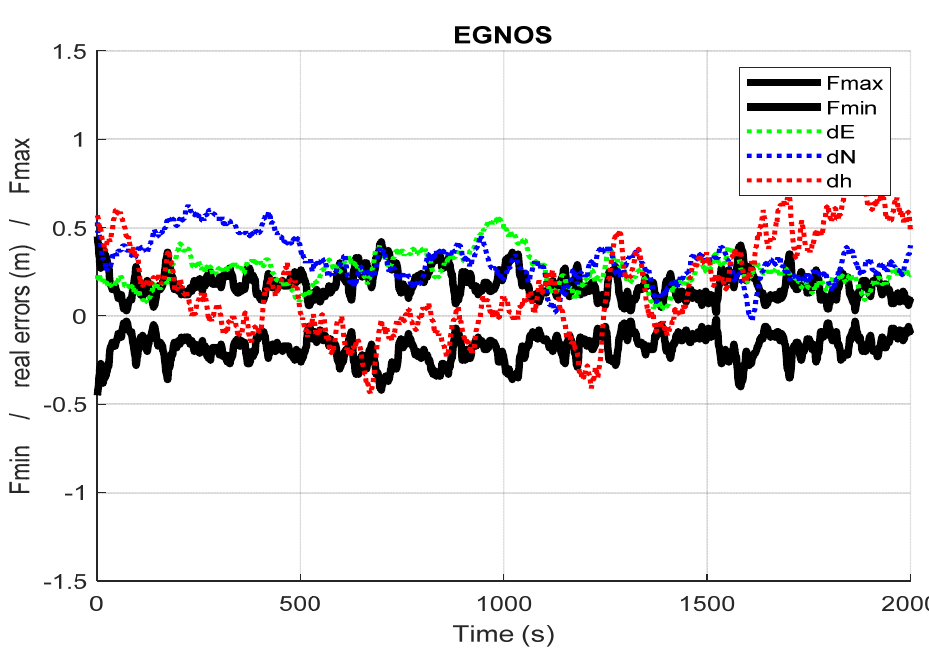
Figure 16. Confidence intervals for the calculated 3D error ( 𝐹𝑚𝑖𝑛 ; 𝐹𝑚𝑎𝑥 ) with respect to the real horizontal and vertical errors, for the dual receiver EGNOS system and C1C+C1W codes.